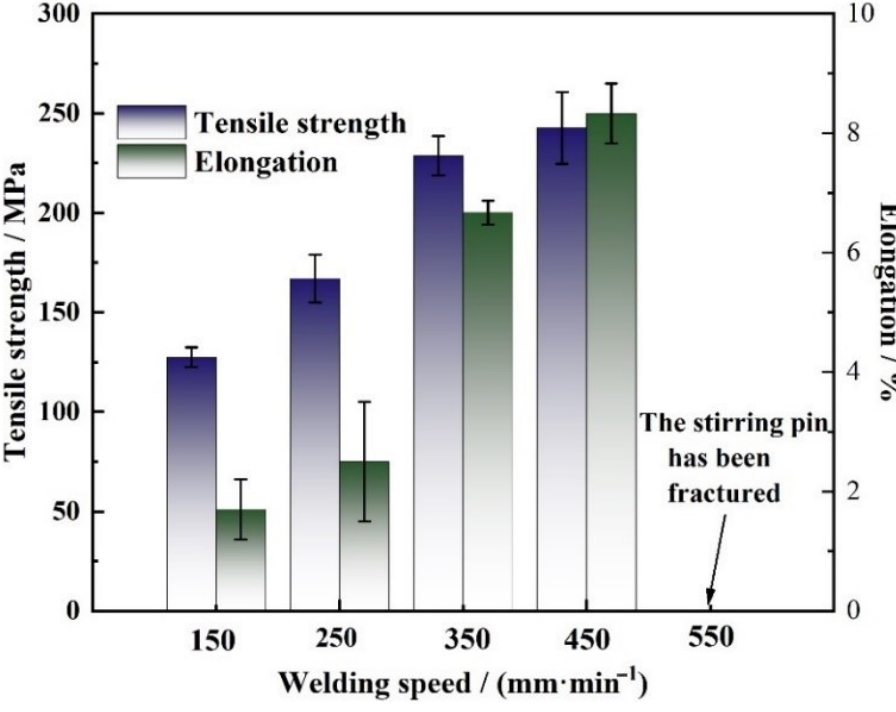
Figure 10. Tensile properties of the joints welded at different welding speeds.